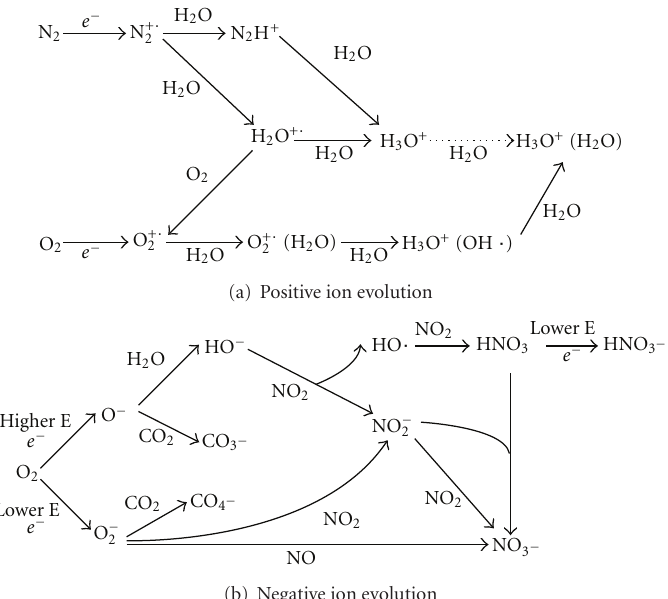
Figure 8: Principal ion reactions and formation the positive and negative ions after air ionization by the coronal discharge [20].